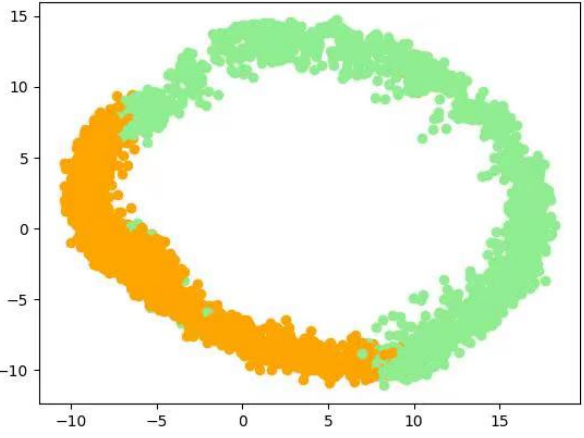
Figure 5. Cluster visualization.